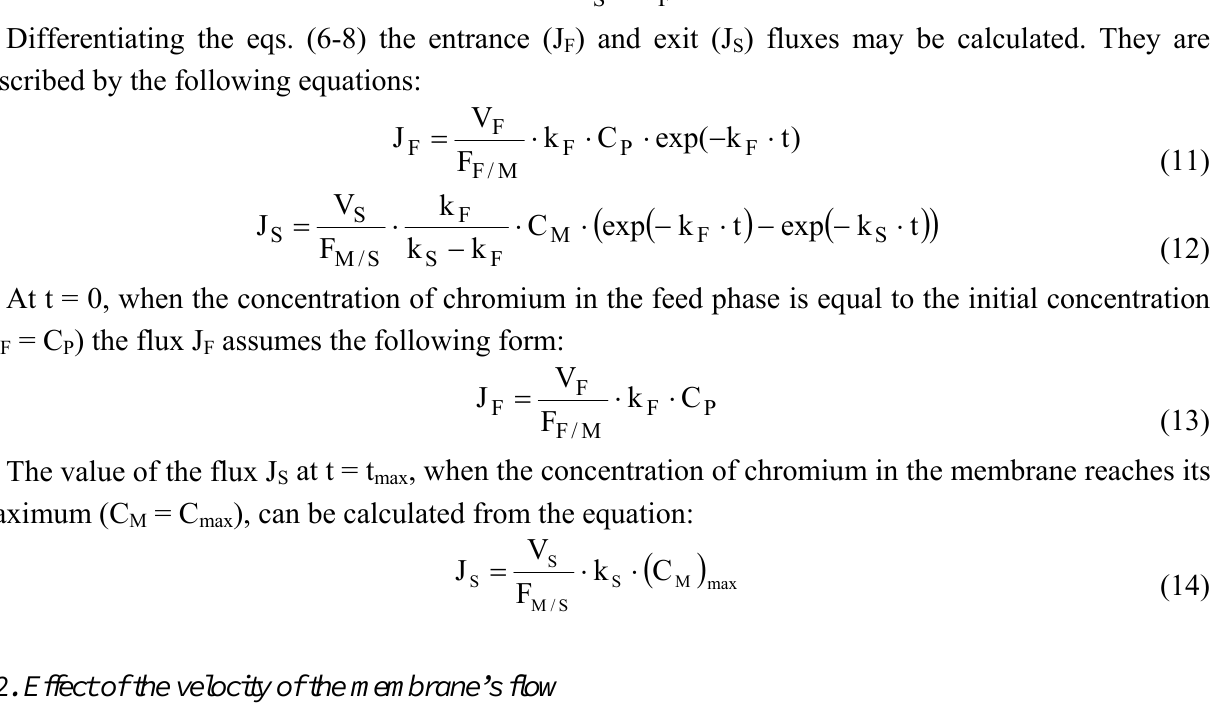
Figure 3. Changes of chromium(III) concentration in particular phases with time for three different flow velocity of the membrane: (a) w = 0.0027 m·s -1 , (b) w = 0.0034 m·s -1 , (c) w = 0.0049 m·s -1 and initial chromium concentration C ▬ -